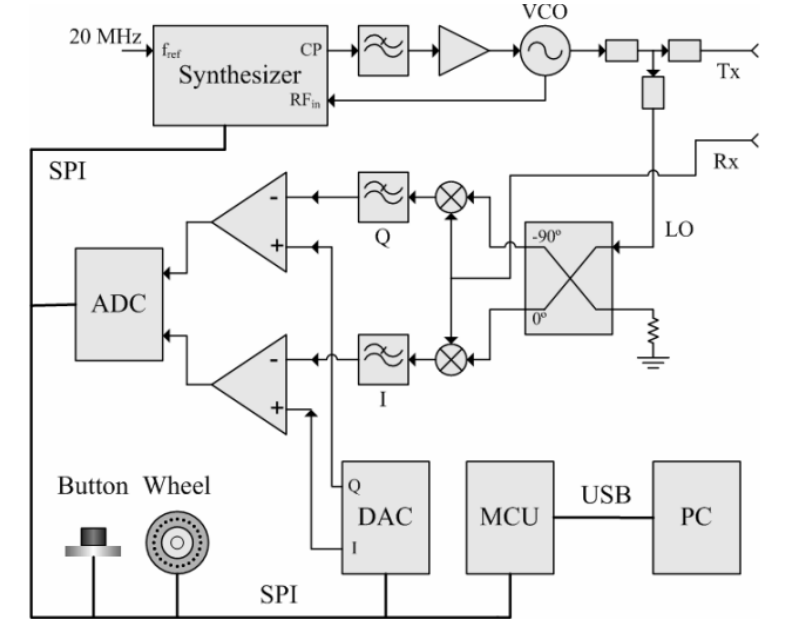
Figure 2. Block diagram of RASCAN-5 electronic